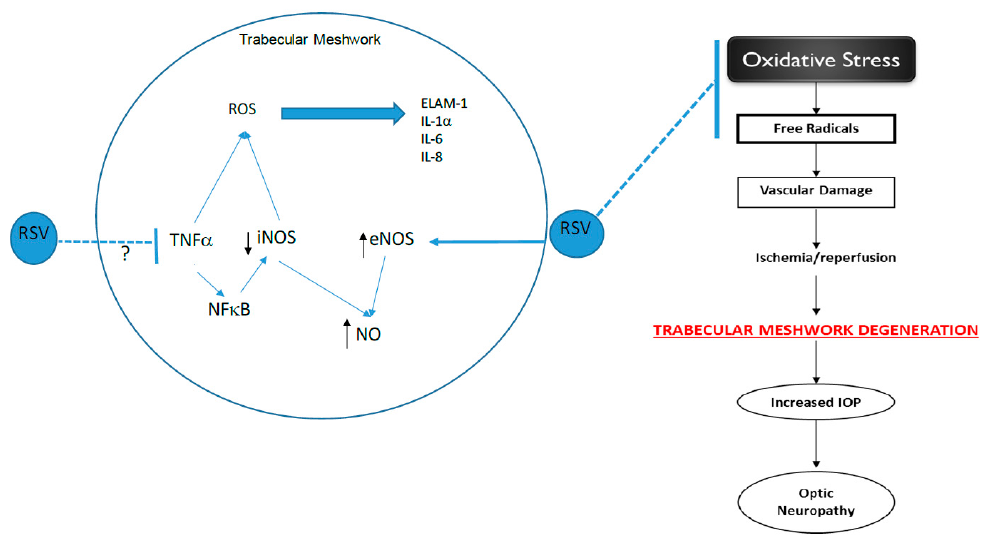
Figure 7. Schematic overview of the mechanisms underlying the beneficial e ff ects of resveratrol on the trabecular meshwork (TM). Our data demonstrated that RSV inhibited iNOS expression but increased eNOS and NO levels in TM cells. We suspect that RSV may inhibit iNOS by blocking TNF- α ; thus, preventing vascular damage, which ultimately leads to TM degeneration.